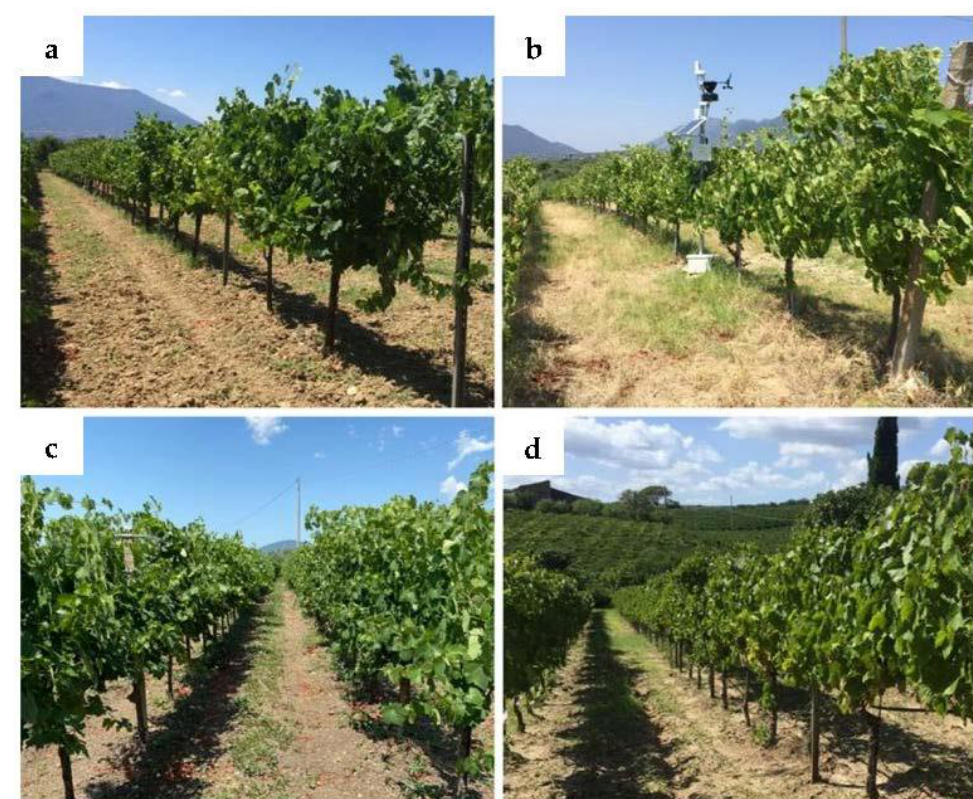
Figure 6. The four experimental sites Santa Lucia ( a ), Calvese ( b ), Grottole ( c ), Acquefredde ( d ) vine-